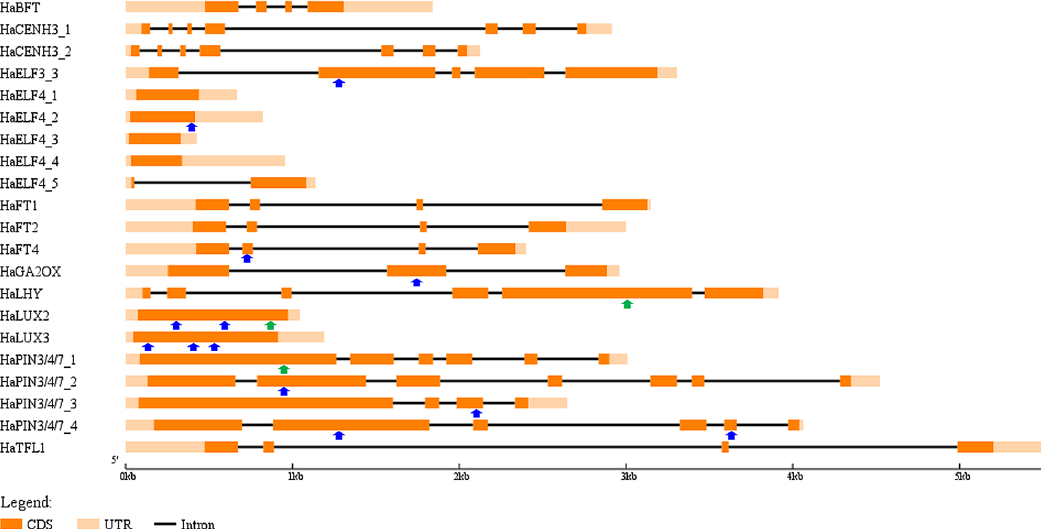
Figure 1. Structure of genes screened for mutations. Dark orange boxes indicate the exons. Lines linking exons represent introns. Light orange boxes indicate the UTRs. Blue and green arrows represent the position of validated heterozygous and homozygous mutations,